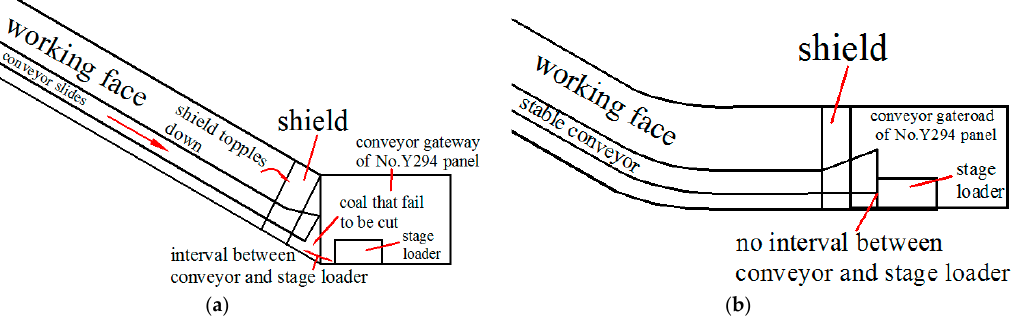
Figure 11. Longwall equipment situation at the connection of the face to the gateway. ( a ) Conventional layout and ( b ) LMSG